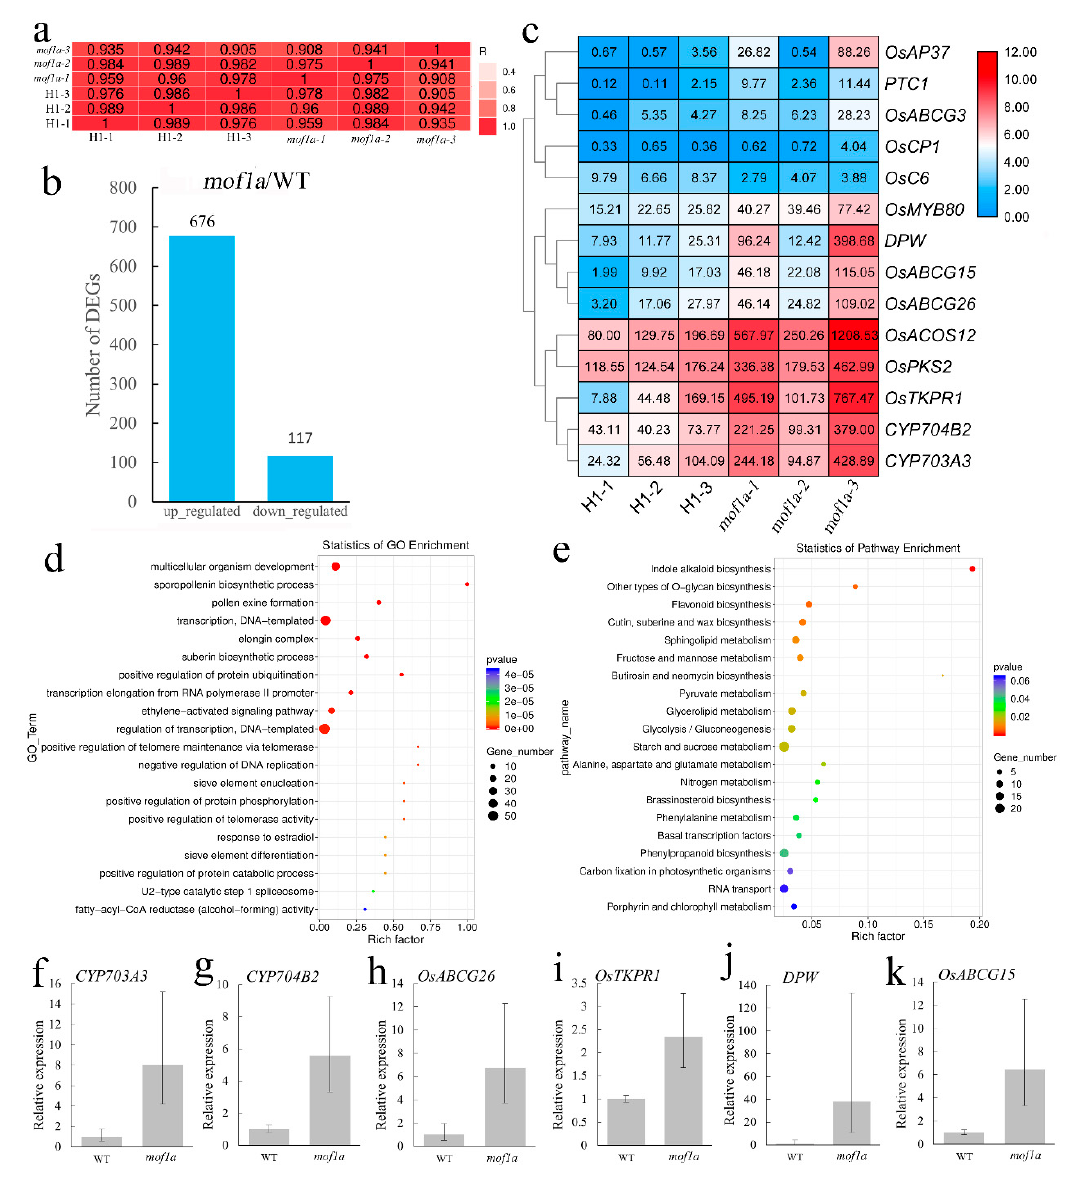
Figure 5. RNA-seq of mof1a and WT anthers during meiosis. ( a ) The Pearson correlation of RNA-seq between three biological replicates of mof1a and H1. ( b ) Number of DEGs that were identified from mof1a . ( c ) Hierarchical cluster analysis of average expression level (FKPM) of 14 tapetum related DEGs. Red indicates a relatively high expression level, while blue indicates a relatively low expression level. ( d ) Gene ontology enrichment of DEGs in mof1a . ( e ) KEGG pathway enrichment of DEGs in mof1a . ( f – k ) Expression levels of CYP703A3 ( f ), CYP704B2 ( g ), OsABCG26 ( h ), OsTKPR1 ( i ), DPW ( j ), and OsABCG15 ( k ) in WT and mof1a anthers during microsporogenesis were analyzed using qRT-PCR. Ubiquitin gene was used as an internal control. The grey bars denote the mean expression of each gene (three independent replicates) and the error bars indicate the ± SD of three independent replicates.